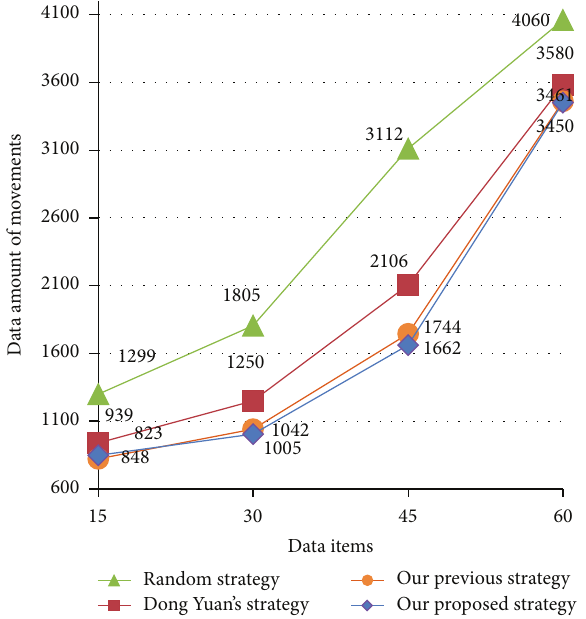
Figure 5: Total time consumed by data movements without fixed- position